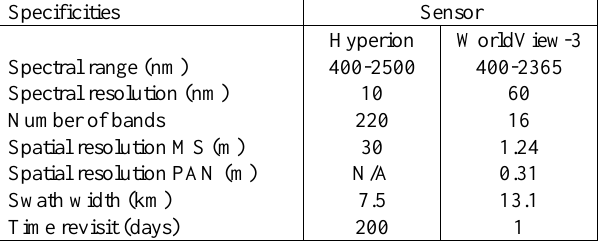
Table 1. Hyperion and WorldView-3